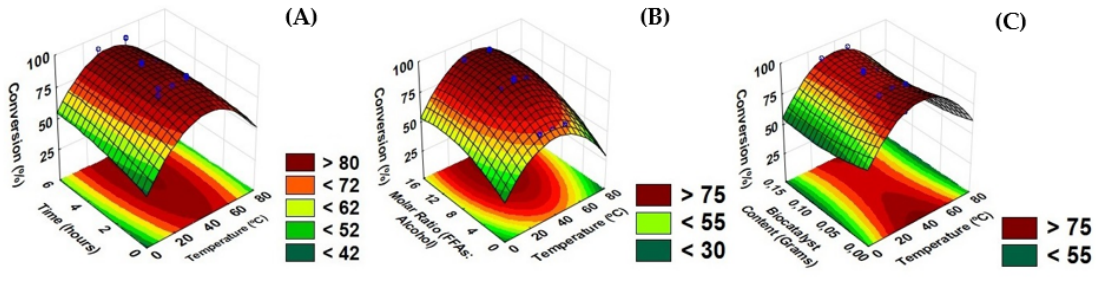
Figure 3. Response surfaces for ( A ) temperature versus time; ( B ) temperature versus molar ratio (fatty acid: alcohol); ( C ) Temperature versus biocatalyst content; reaction medium: babassu free fatty